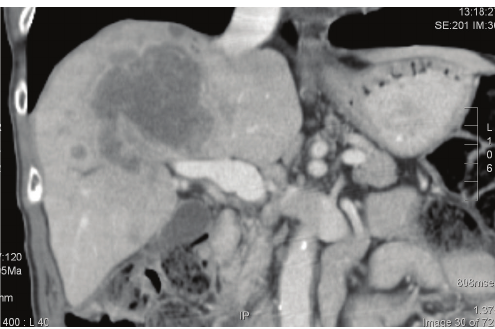
Figure 3: Impressive bile duct dilatation in patient B before stent- ing.